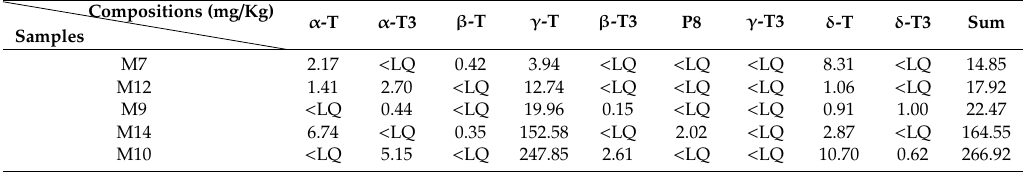
Table 2. Tocopherol compositions (mg / Kg) of five seed oil samples.